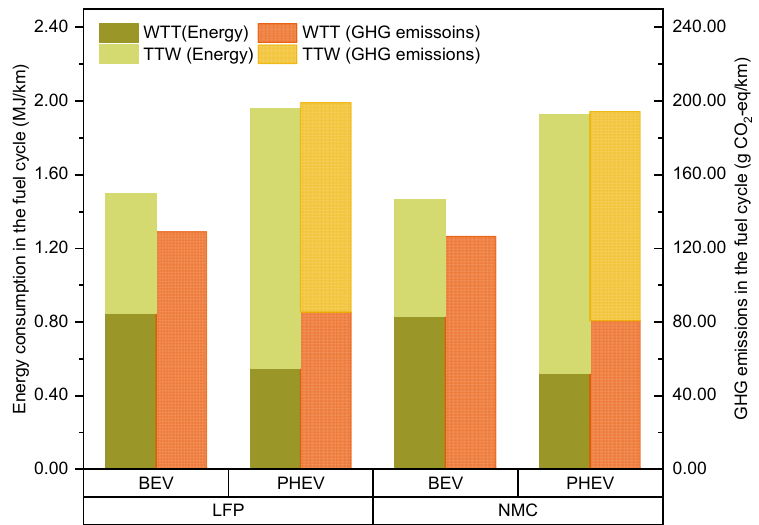
Figure 2. The energy consumption and GHG emissions in the fuel cycle.